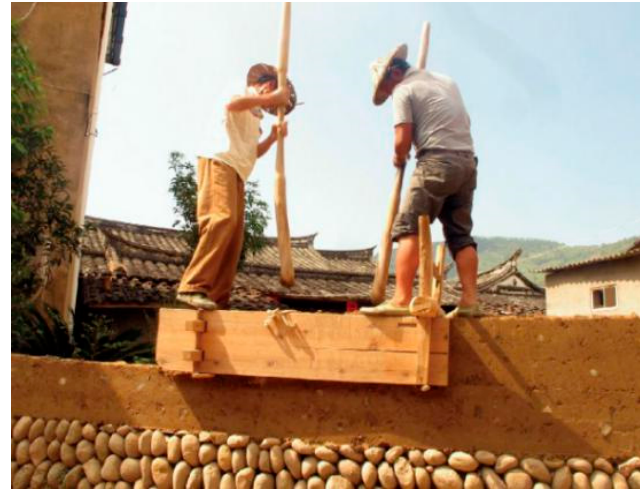
Figure 4. Rammed earth method